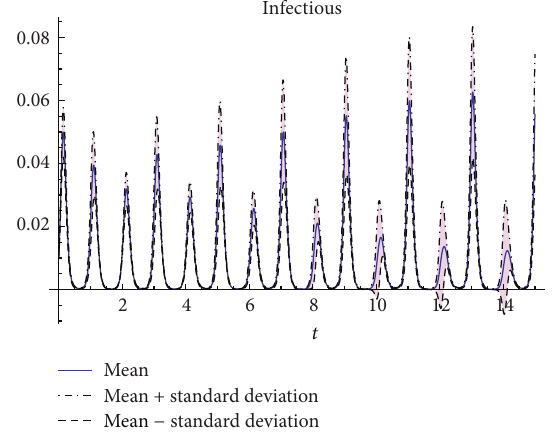
Figure 11: Approximations of the expectation (solid line) and plus/minus standard deviation (dashed lines) to infected ( 𝐼(𝑡) ) on the interval [0, 15] in Example